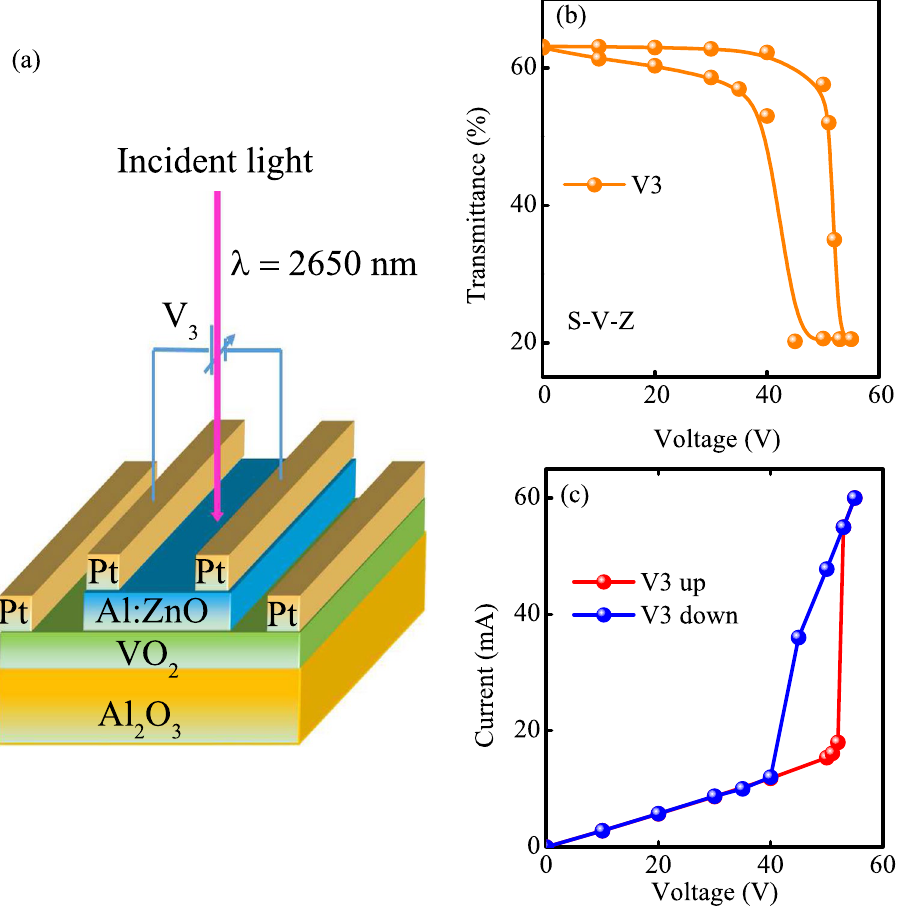
Figure 10. ( a ) The structure of the S-V-Z device. ( b ) The voltage dependent transmittance of the S-V-Z device. ( c ) The I–V curve of the device with